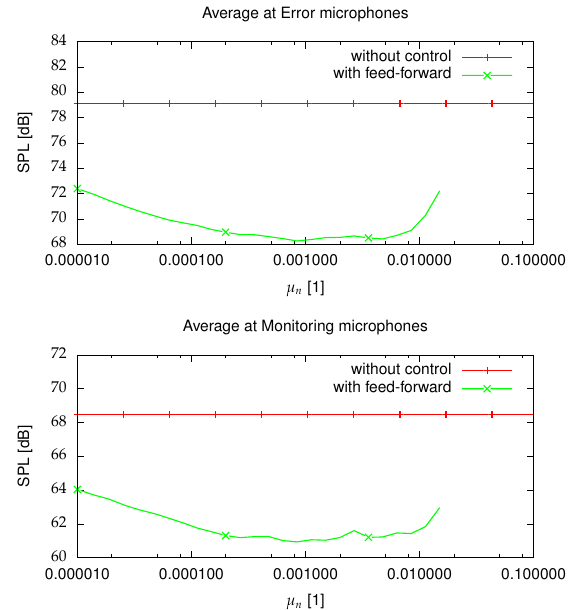
Figure 6. Average SPL at error and monitor microphones for reproduced spinning noise at 1200 rpm for a different µ n after 15 minutes, γ = 0.0001.